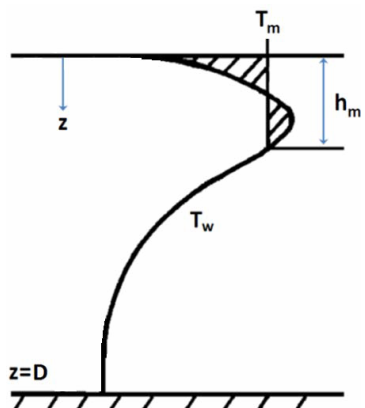
Figure 2. Convective mixing at the surface of the water reservoir of depth D due to the unstable temperature profile ( T w ) associated with subsurface radiation absorption (adapted from Dake and Harle- man, 1969). Based on Eq. (10), the hatched areas on the left and right hand side of T m are equal and represent the transfer of subsur- face heat accumulation to the